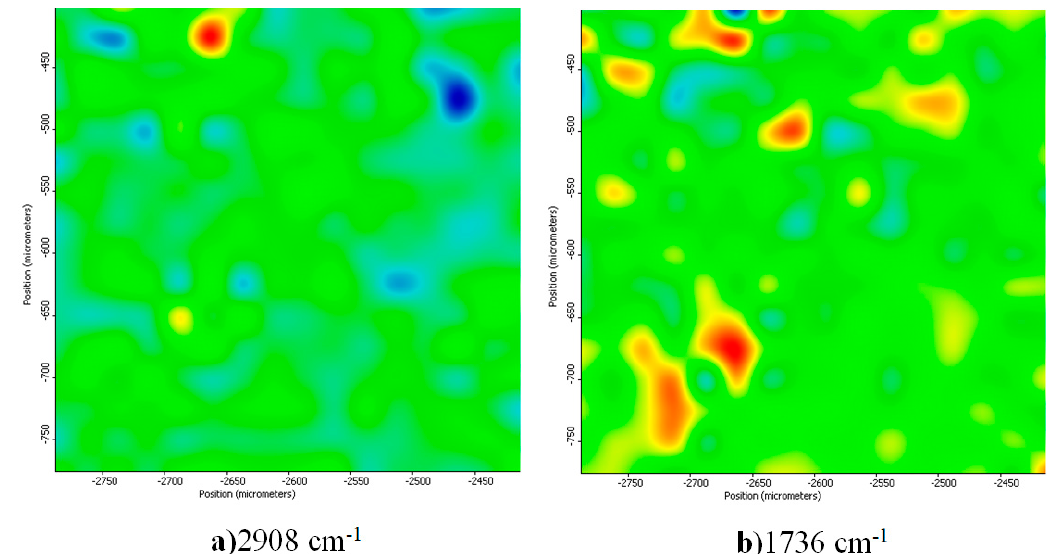
Figure 5. InfraRed spectra of NanoAgWDs.